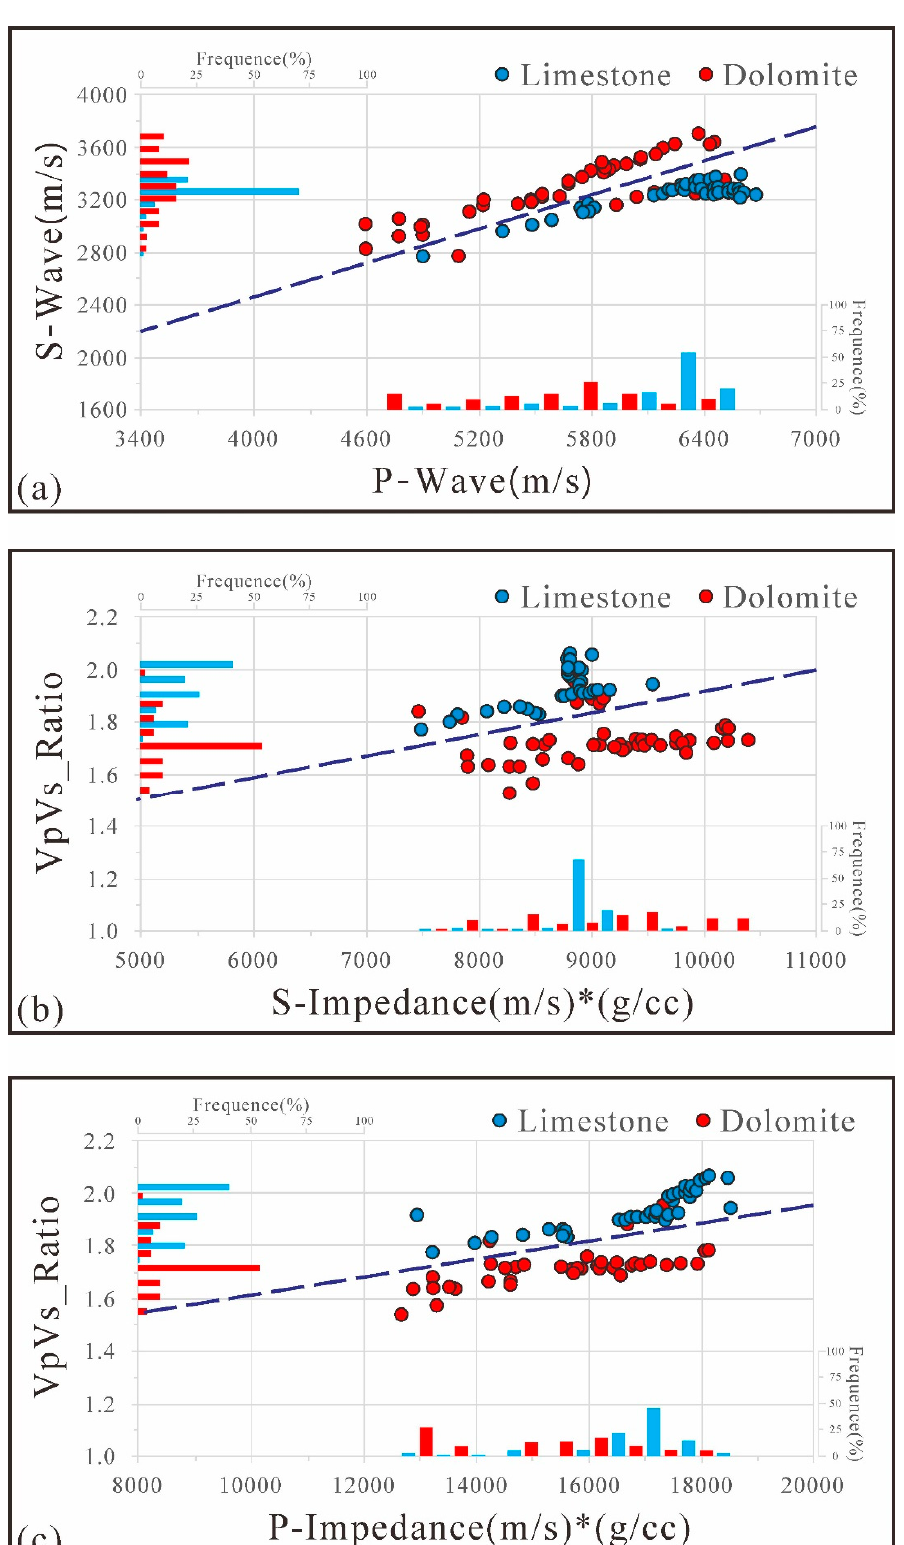
Figure 7. Statistical analysis of lithology of logging curves. ( a ) The cross plot between the P-wave velocity and the S-wave velocity, showing the samples between the dolomite reservoir and the surrounding limestones are mixed; ( b ) The cross plot between the transverse wave and the velocity ratio of the longitudinal wave, showing the samples between the dolomite reservoir and the surrounding limestones are mixed; ( c ) The cross plot between the P-wave impedance and the P-wave velocity wave, showing the sensitive petrophysical parameter pairs of the dolomite reservoir and surrounding